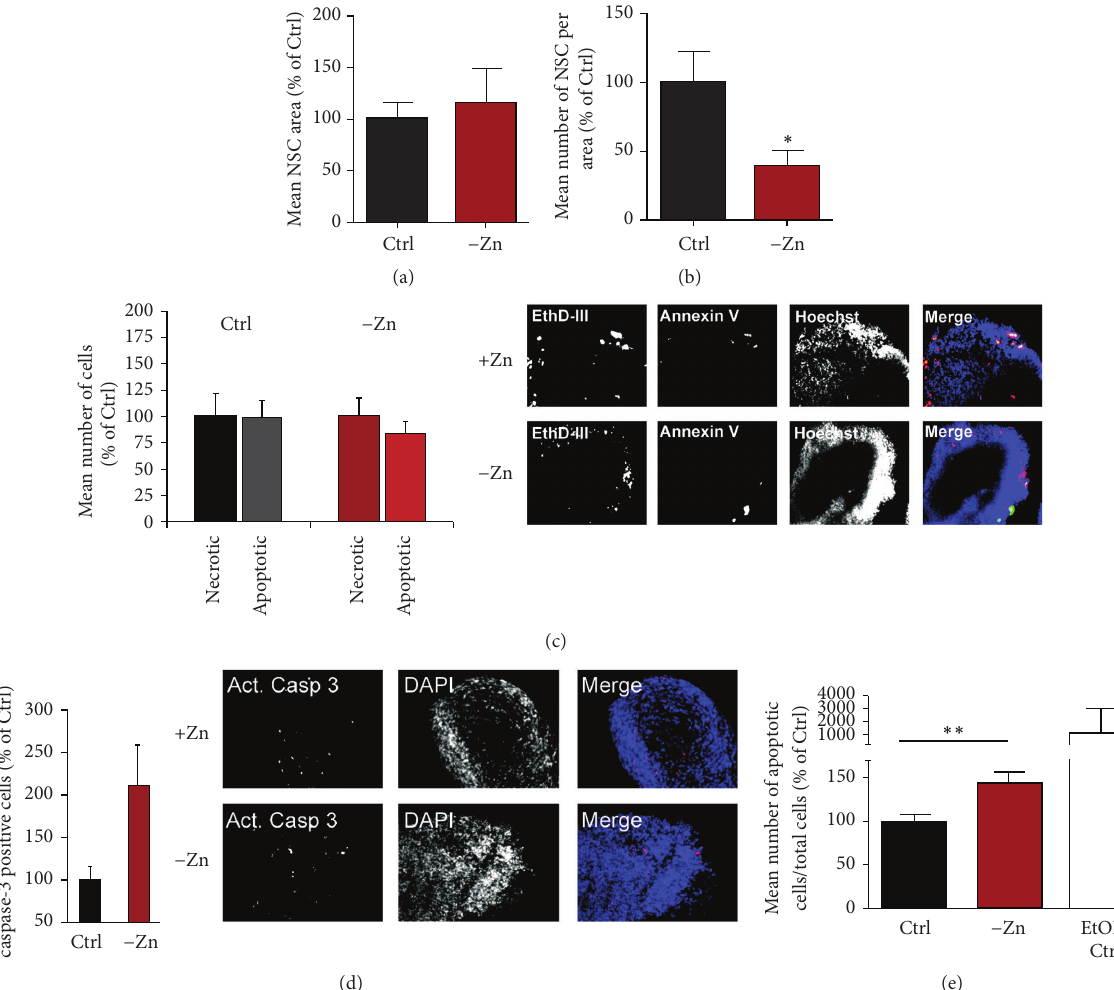
Figure 3: Zinc deficiency significantly impairs iPS cell differentiation. (a) The average size of NSC clusters is not significantly altered upon zinc deficiency. (b) The mean number of NSC clusters per area measured on a 10cm petri dish is significantly reduced in zinc deficient conditions ( 𝑡 -test, 𝑝 = 0.0281 ; 𝑛 = 8 ). (c) Apoptosis and necrosis were evaluated for the NSC stage during differentiation. No difference in the number of cells labeled with markers for apoptosis or necrosis was found between zinc deficient and zinc sufficient media ( 𝑡 -test, 𝑛 = 20 ). Right panel: exemplary images of NSC stained with annexin V labeled with FITC (apoptotic cells) and ethidium homodimer III (necrotic cells) and DAPI (total number of cells). (d) The mean number of cells showing signals specific for cleaved caspase-3 was increased under zinc deficient conditions seen as trend ( 𝑡 -test, 𝑝 = 0.09 ; 𝑛 = 20 ). Right panel: exemplary images of NSC stained with anti-active caspase-3 antibody and DAPI. (e) A significant increase in apoptotic cells was detected in embryoid bodies grown under zinc deficient conditions using the ApoTox-Glo™ Triplex Assay ( 𝑡 -test, 𝑝 = 0.0098 ; 𝑛 = 12 ). ∗ 𝑝 ≤ 0.05 ; ∗∗ 𝑝 ≤ 0.01